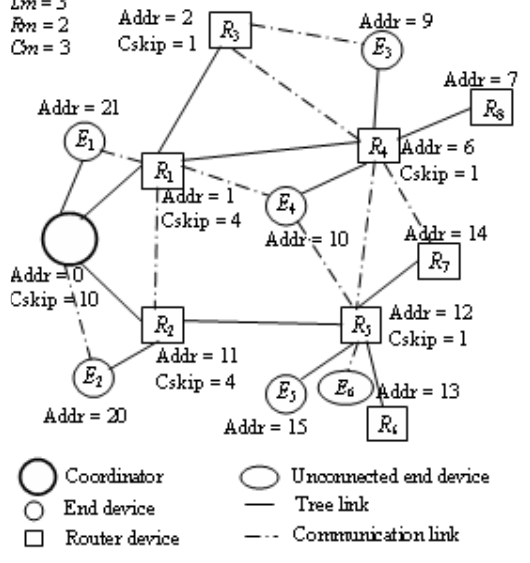
Figure 1. An example of ZigBee network